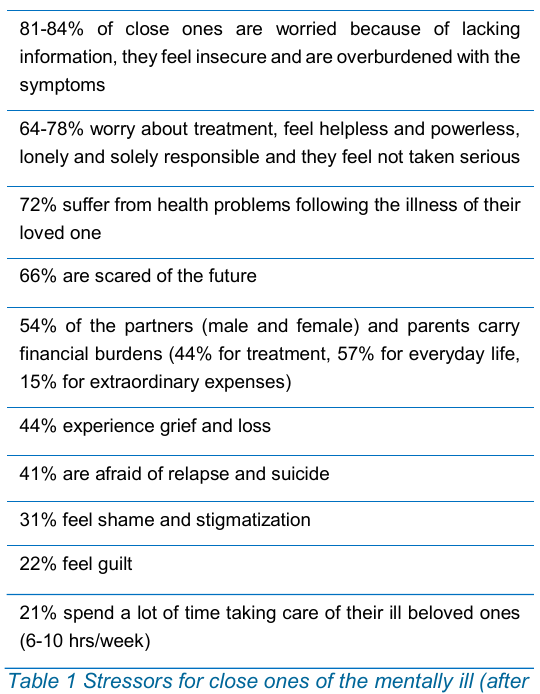
Table 1 Stressors for close ones of the mentally ill (after Kurt